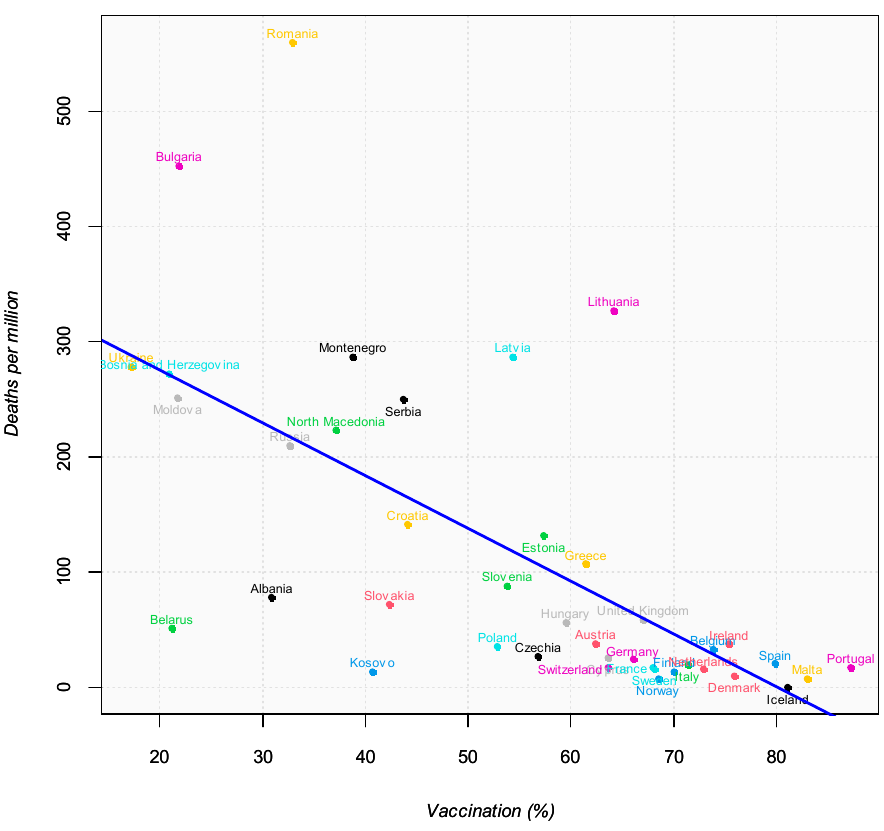
Figure 9. Vaccination coverage and deaths according to European Countries as of 31 October 2021.